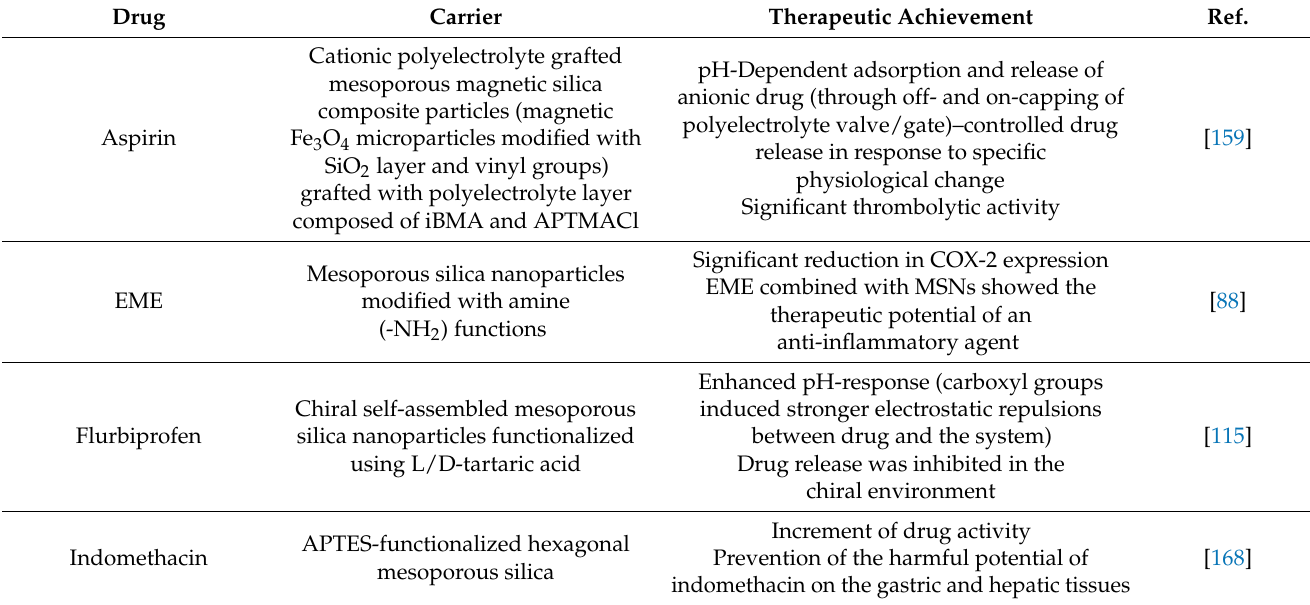
Table 5. Therapeutic achievements resulting from the usage of mesoporous materials-based drug delivery systems